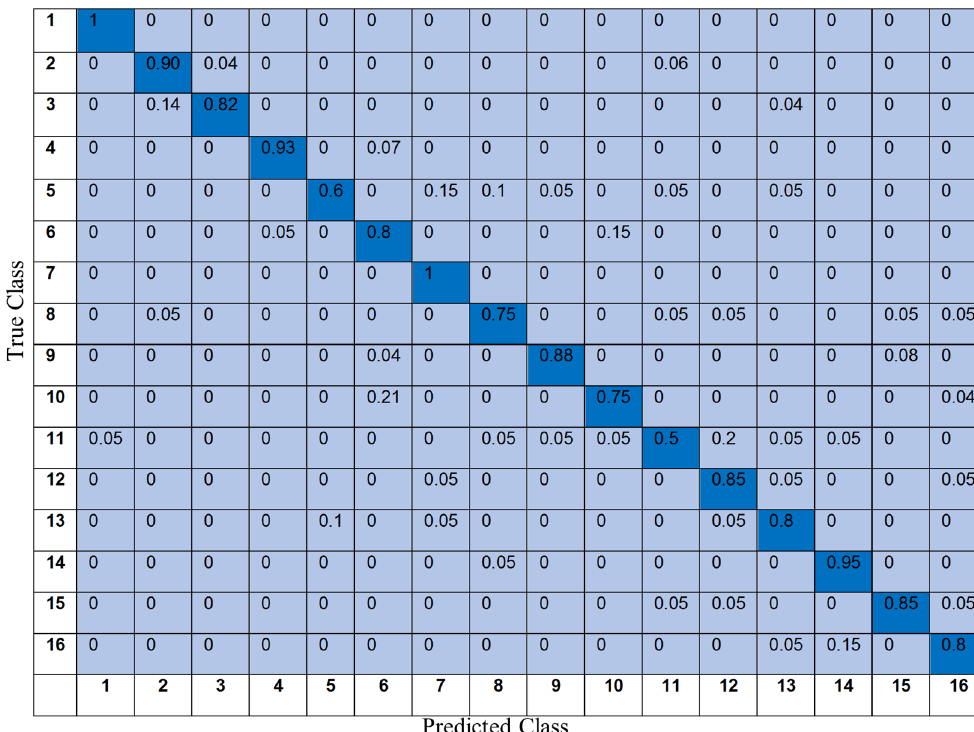
Figure 10. Activity monitoring: normalised confusion matrix for the fold with accuracy of